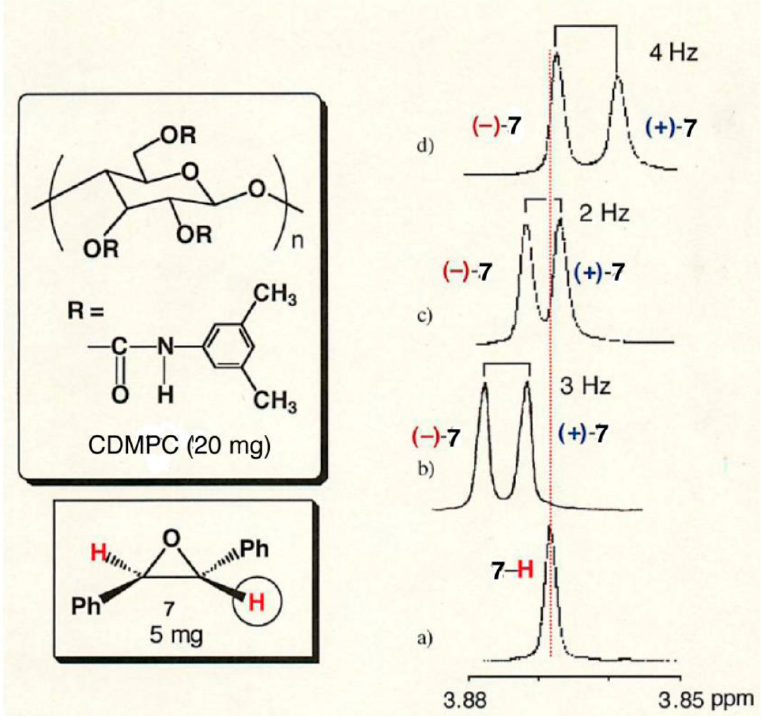
Figure 5. 1 H-NMR of 7 in the absence ( a ) and presence of CDMPC-4 ( b ); CDMPC-7 ( c ) and CDMPC-26 ( d ) (500 MHz, 23 °C, chloroform- d 1 , [CDMPC]/[ 7 ] = 1.3).